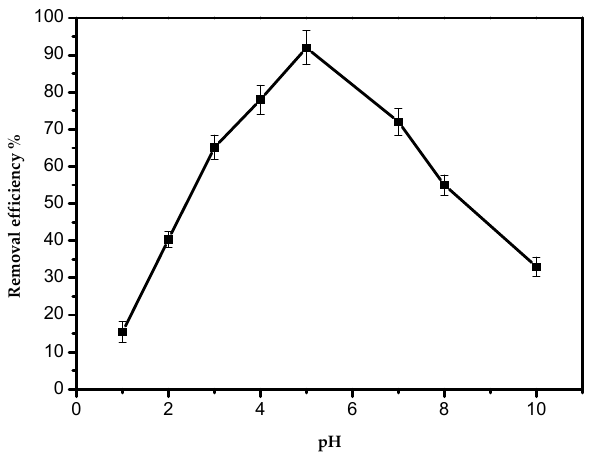
Figure 4. Effect of the pH on the removal efficiency of Pb(II) ions by AILP.